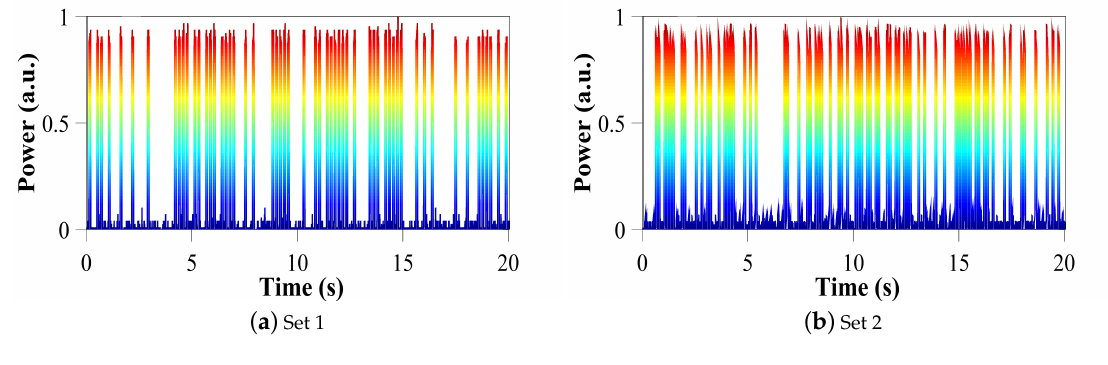
Figure 7. Asynchronous